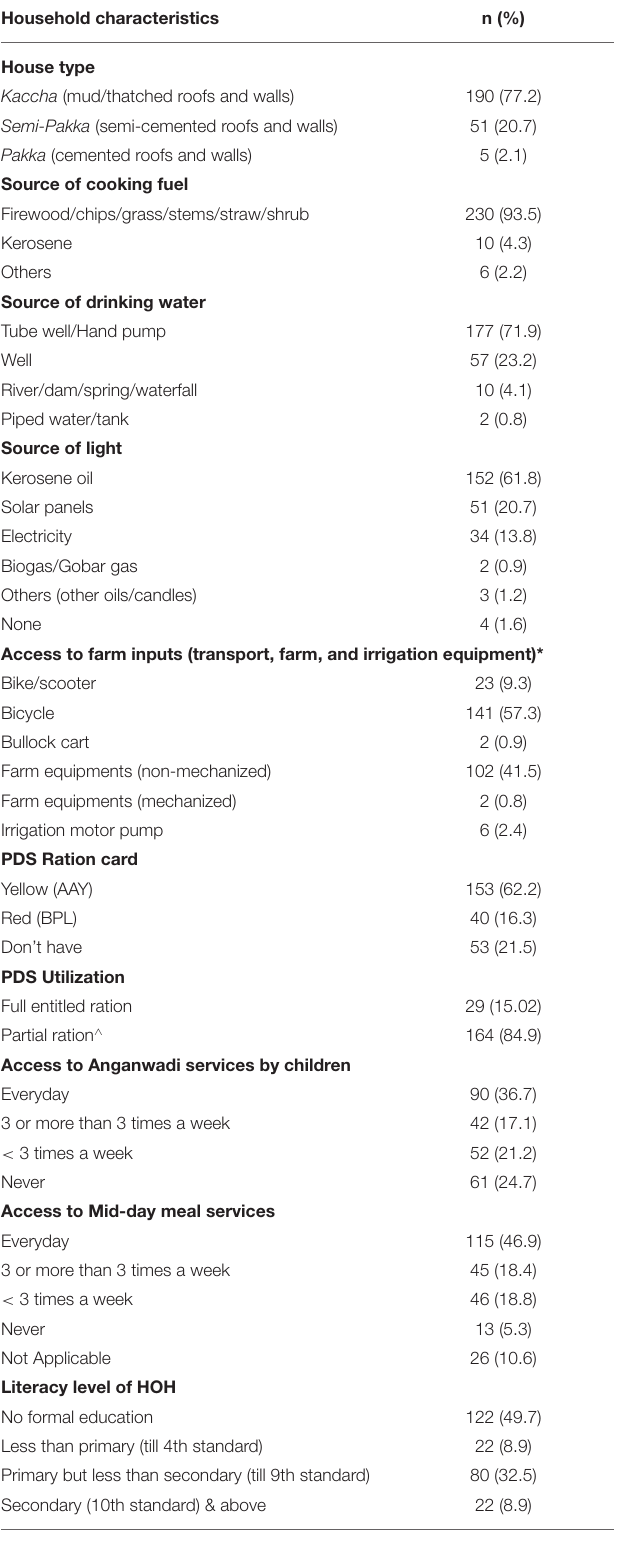
TABLE 2 | Household characteristics, food production and access of Sauria Paharia community in Jharkhand, India ( n = 246). Household